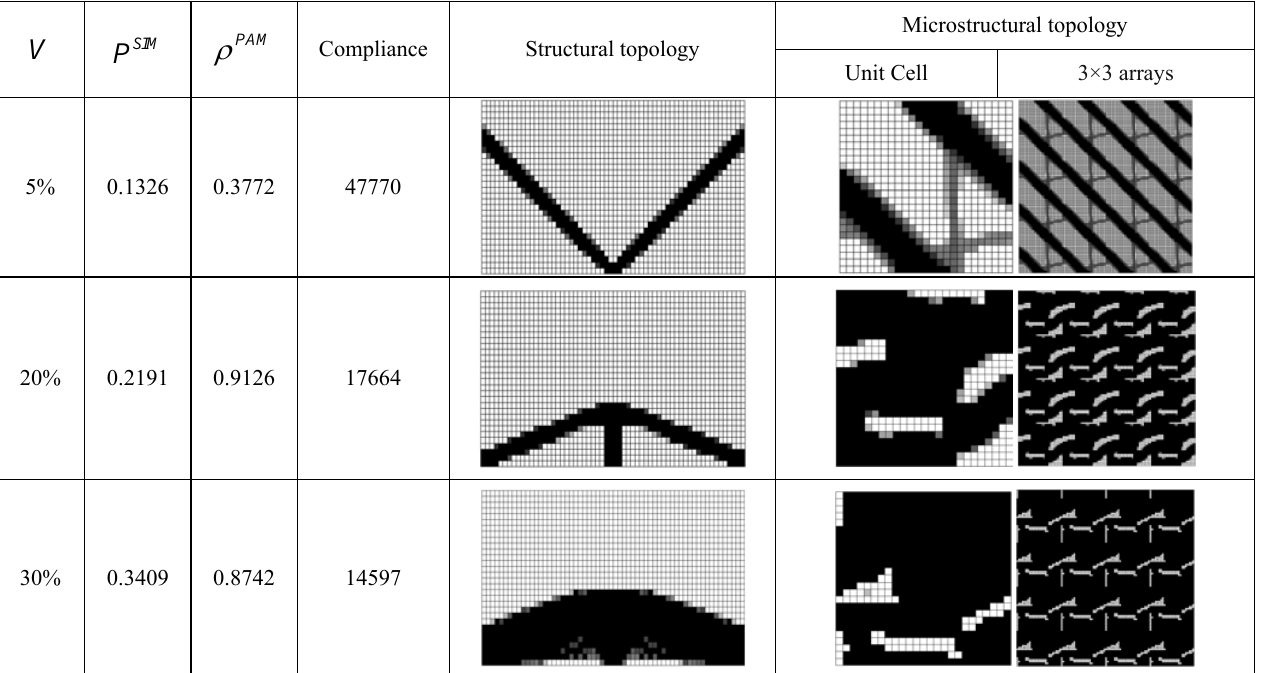
Table 2 Influence of base material volume on the concurrent optimization